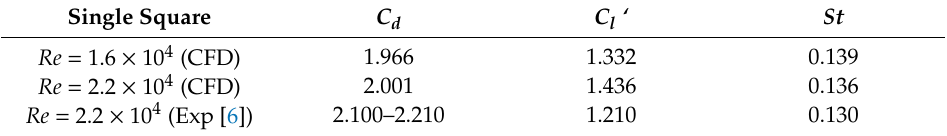
Figure 4. Distribution of transverse velocity U flow around a single square cylinder (m / s). Table2.